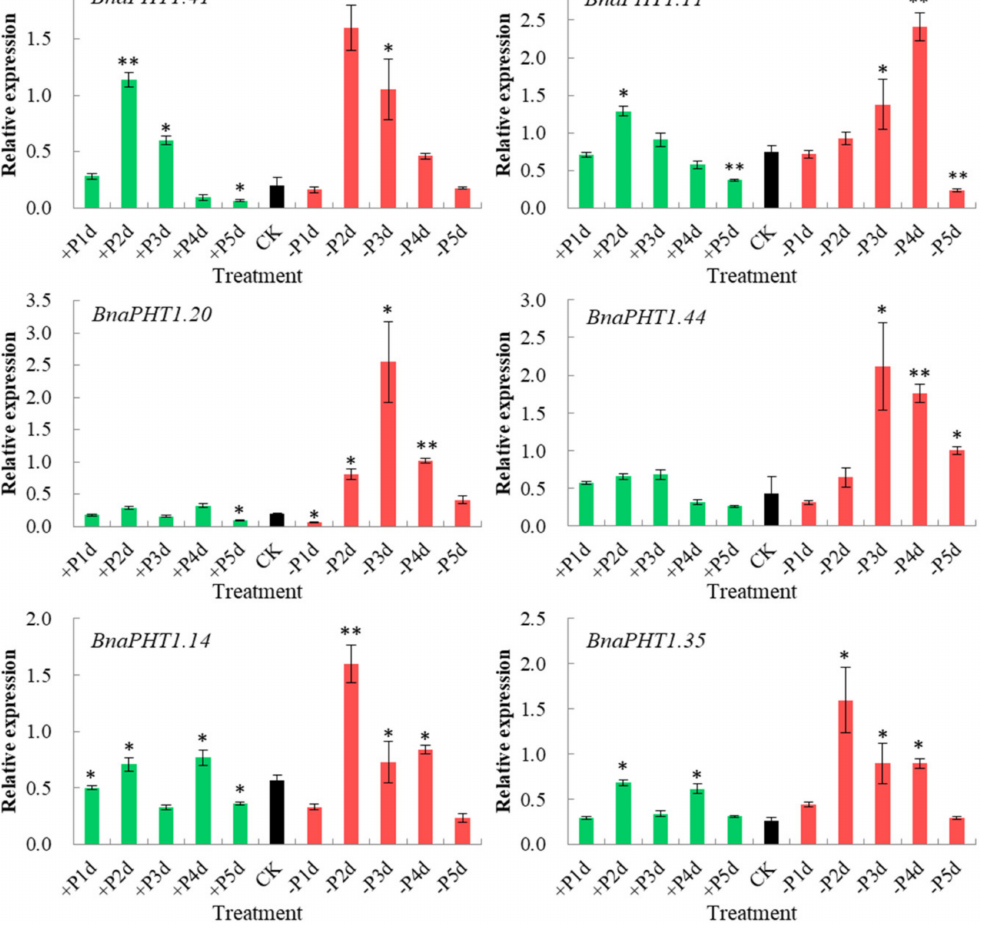
Figure 8. Expressions of six BnaPHT1s under low- or high- Pi treatments by qRT-PCR. The transcript levels were determined in B. napus seedling roots by qRT-PCR method under low (-Pi) or high Pi ( + Pi) conditions. CK: normal Pi condition; + P1d~ + P5d: + Pi condition on 1-5 day (s); -P1d~-P5d: -Pi condition on 1~5 day (s). The B. napus Actin7 ( BnActin7 ) (GenBank accession no. AF024716) was used as the reference gene. The red bar represents the expressions of BnaPHTs under -Pi conditions; the green bar represents the expressions of BnaPHTs under + Pi conditions; and the black bar represents the expressions of BnaPHTs under normal Pi conditions (CK). Error bars indicate the standard deviation of three independent experiments. *: Significant di ff erence (0.05 > p > 0.01); **: Extremely significant di ff erence ( p <